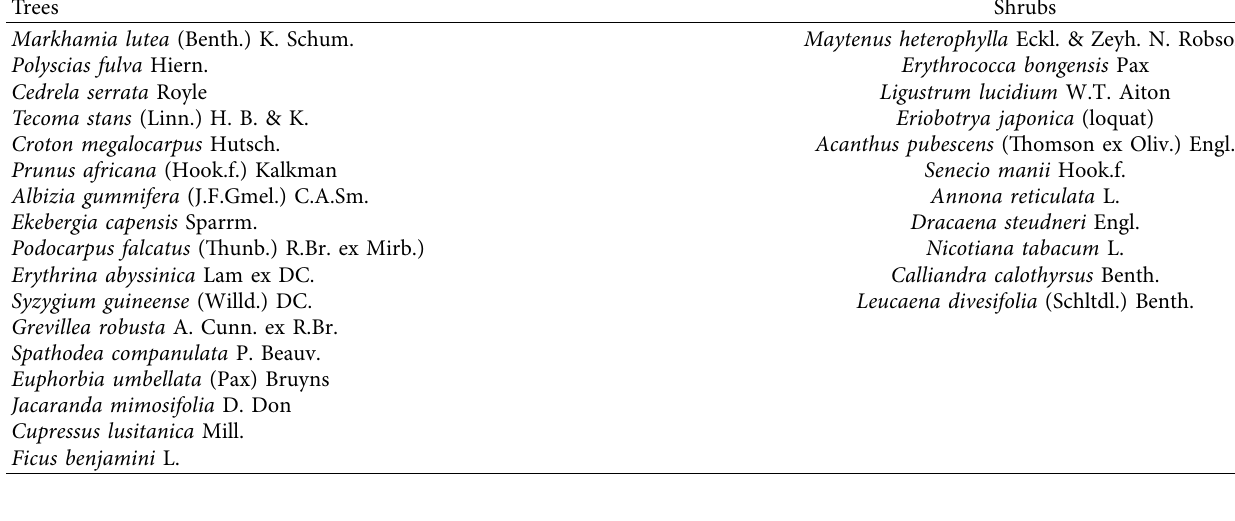
Table 1: Tree and shrub species ranked from the most to the least abundant identified in the self-regenerated secondary forest in Ruhande Arboretum, Huye, Rwanda.